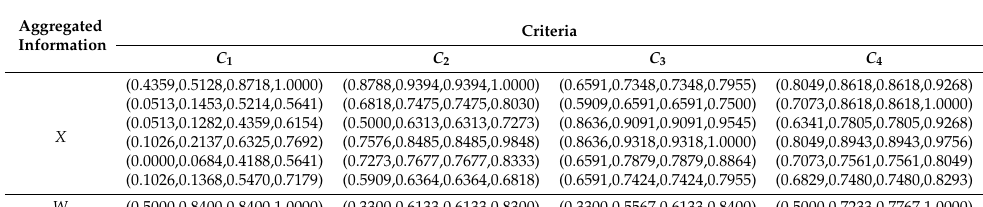
Table 10. Aggregated information of fuzzy information X and fuzzy criteria weights W